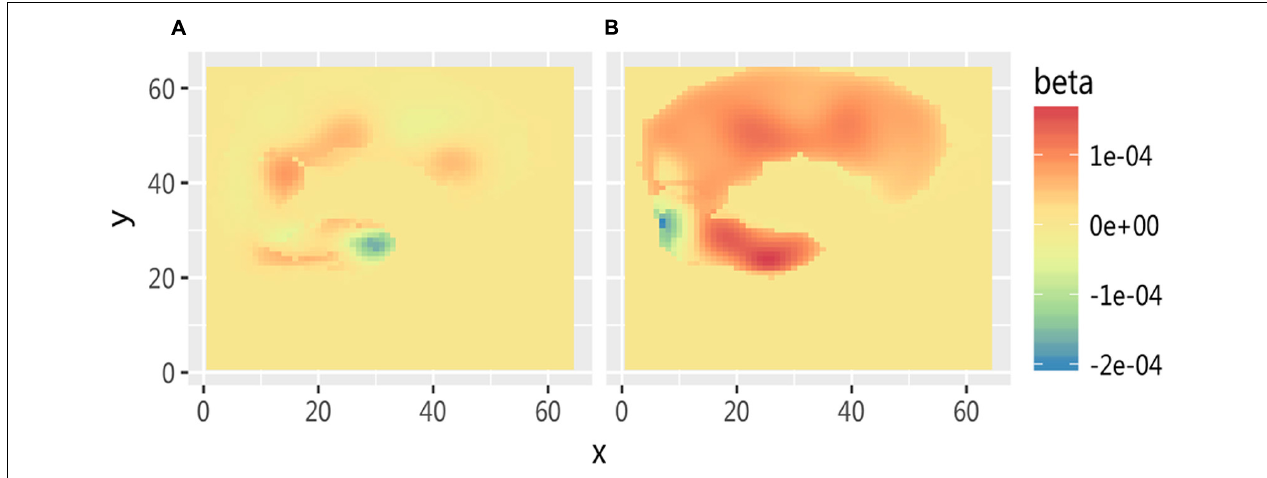
FIGURE 5 | Comparison of cortex activation evoked by stimuli of needle puncture. (A) Medical subjects under the acupuncture condition and (B) non-medical subjects under the acupuncture